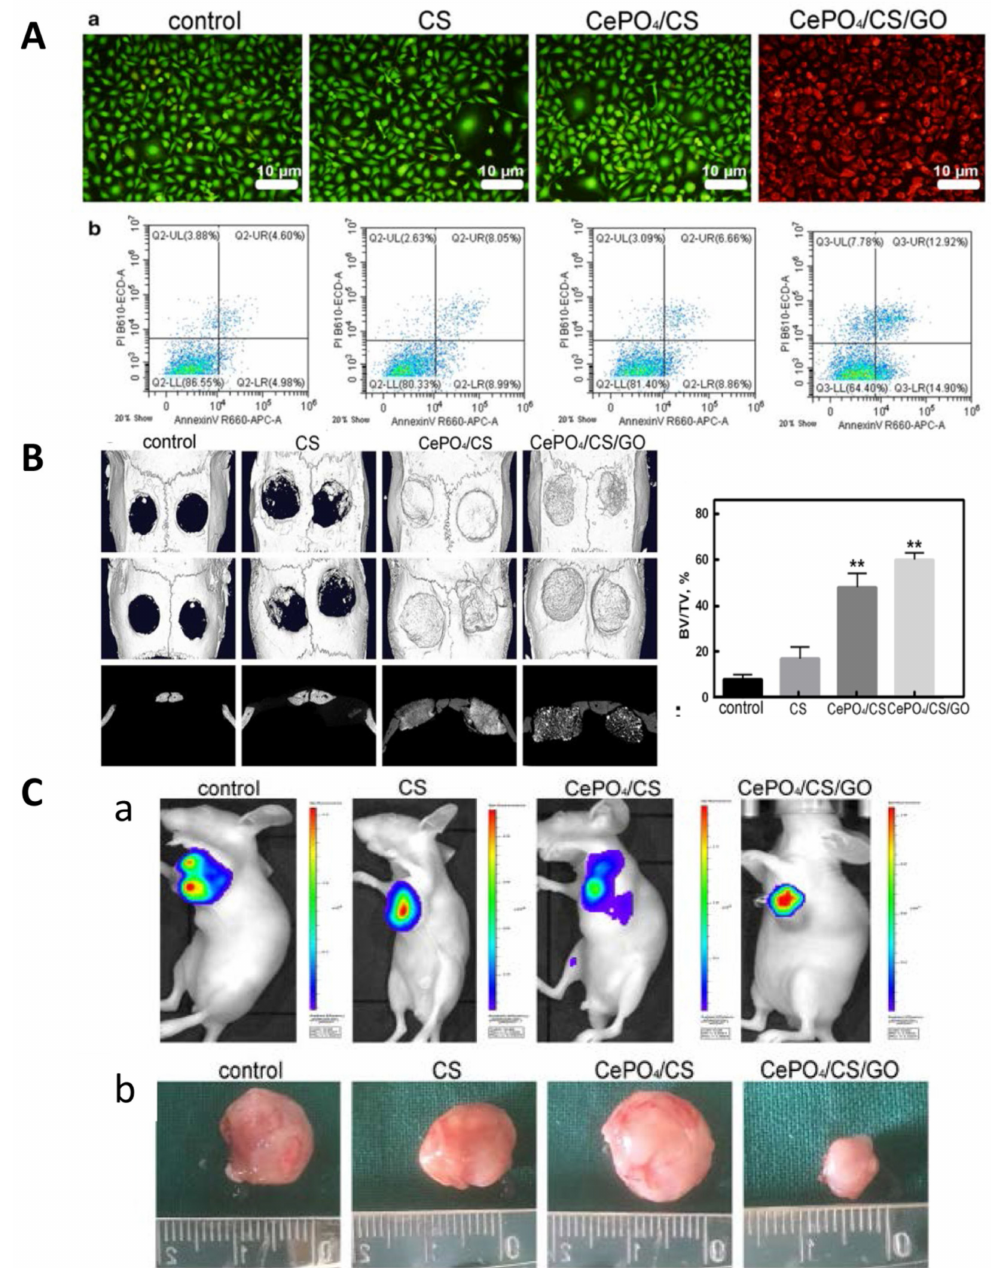
Figure 5. ( A ) ( a ) live-dead cell staining. ( b ) flow cytometry of MDA-MB-231 cells for different groups under NIR laser irradiation for 10 min every day. It was found that the MDA-MB-231 cells in the control, CS and CePO4/CS control groups were live cells, while those in the CePO4/CS/GO group were dead cells (green represents live cells and red represents dead cells). ( B ) Micro-CT images and bone volume/tissue volume (BV/TV) of skulls 3 months after the surgery. ** p < 0.01, vs control. ( C ) ( a ) Fluorescence detection on nude mice after NIR laser irradiation and fluorescence intensity of the CePO4/CS/GO group was significantly lower than the blank, CS and CePO4/CS groups. ( b ) Optical picture of tumors in nude mice. Reproduced from ref. [262] with permission from BioMed Central. Copyright (2021) J